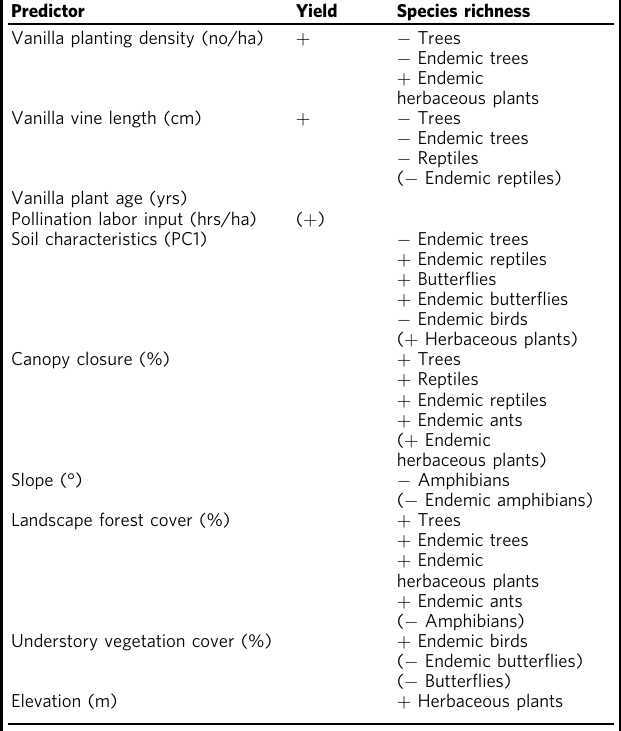
Table 1 Overview of the direction of effects of environmental and management variables on yield and species richness across seven taxa (trees, herbaceous plants, birds, amphibians, reptiles, butter fl ies, and